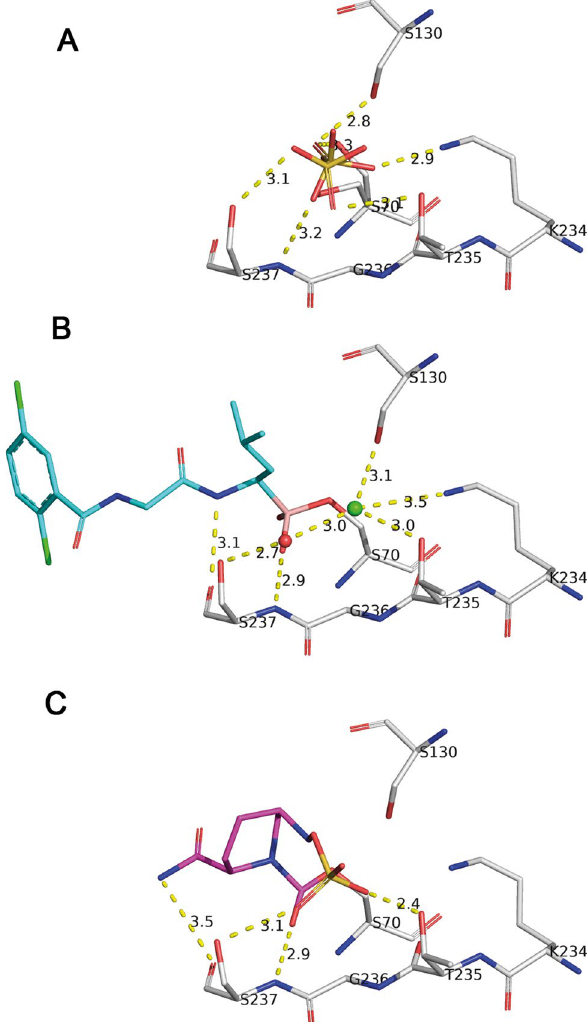
Figure 4. The anion binding site in CTX-M-14 is occupied by a rotational disordered sulphate ion in the native enzyme ( A ). The larger sulphate ion is replaced by a smaller chloride ion upon inhibitor binding and bound Ixazomib is colored in cyan (B ). This anion binding site is occupied by a sulfonate substituent of DBO (Diazabicyclooctane) inhibitors Avibactam, colored in pink ( C ). The hydrogen bonding networks are represented as yellow dashed